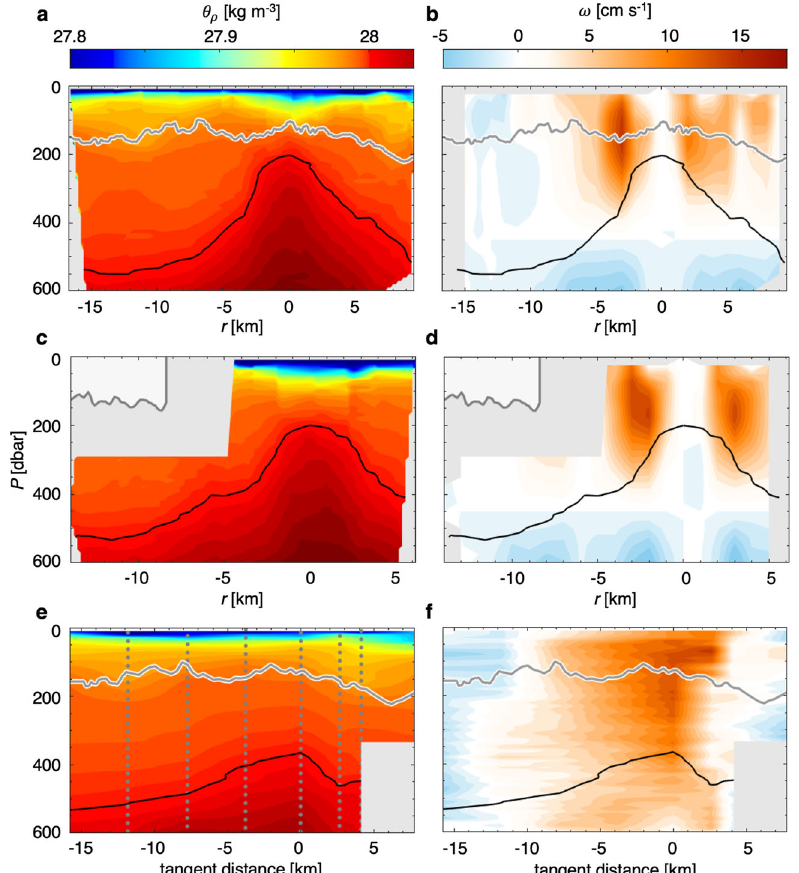
Fig. 7 Eddy azimuthal velocities. a Potential density from glider measurements parallel to the NIS calving front (red lines in Fig. 1b). b Estimated eddy azimuthal velocity (positive clockwise/cyclonic) from the glider data in a . c Potential density from glider measurements perpendicular to the NIS calving front (blue lines in Fig. 1b). d Estimated eddy azimuthal velocity (positive clockwise/cyclonic) from the glider data in c . e Potential density from the ship CTD transect parallel to the NIS calving front (tangent to, not bisecting the eddy). f Measured eddy azimuthal velocity from the ship LADCP, concurrent with the ship CTD in e . LADCP current velocities in Earth-normal components are provided in Fig. S7. Grey lines in a , b , e , and f and light grey polygons in c and d provide the nearby ice draft. Vertical dashed lines in e show the extent of the data (ship CTDs) before interpolation. Black contours show the upper extent of the HSSW. The grey background signi fi es regions of no